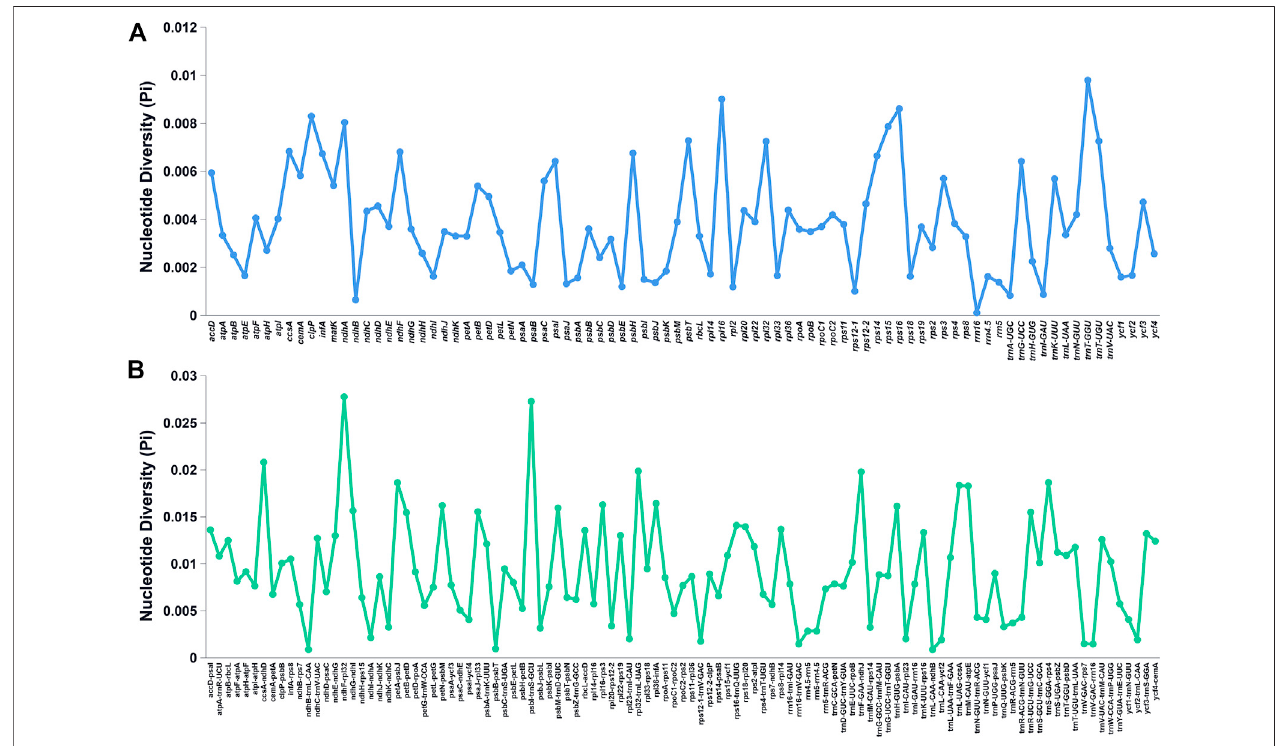
FIGURE 5 | Nucleotide diversity of various shared regions in the chloroplast genomes of Bidens species. (A) Pi values in the gene regions. (B) Pi values in the intergenic spacer regions.